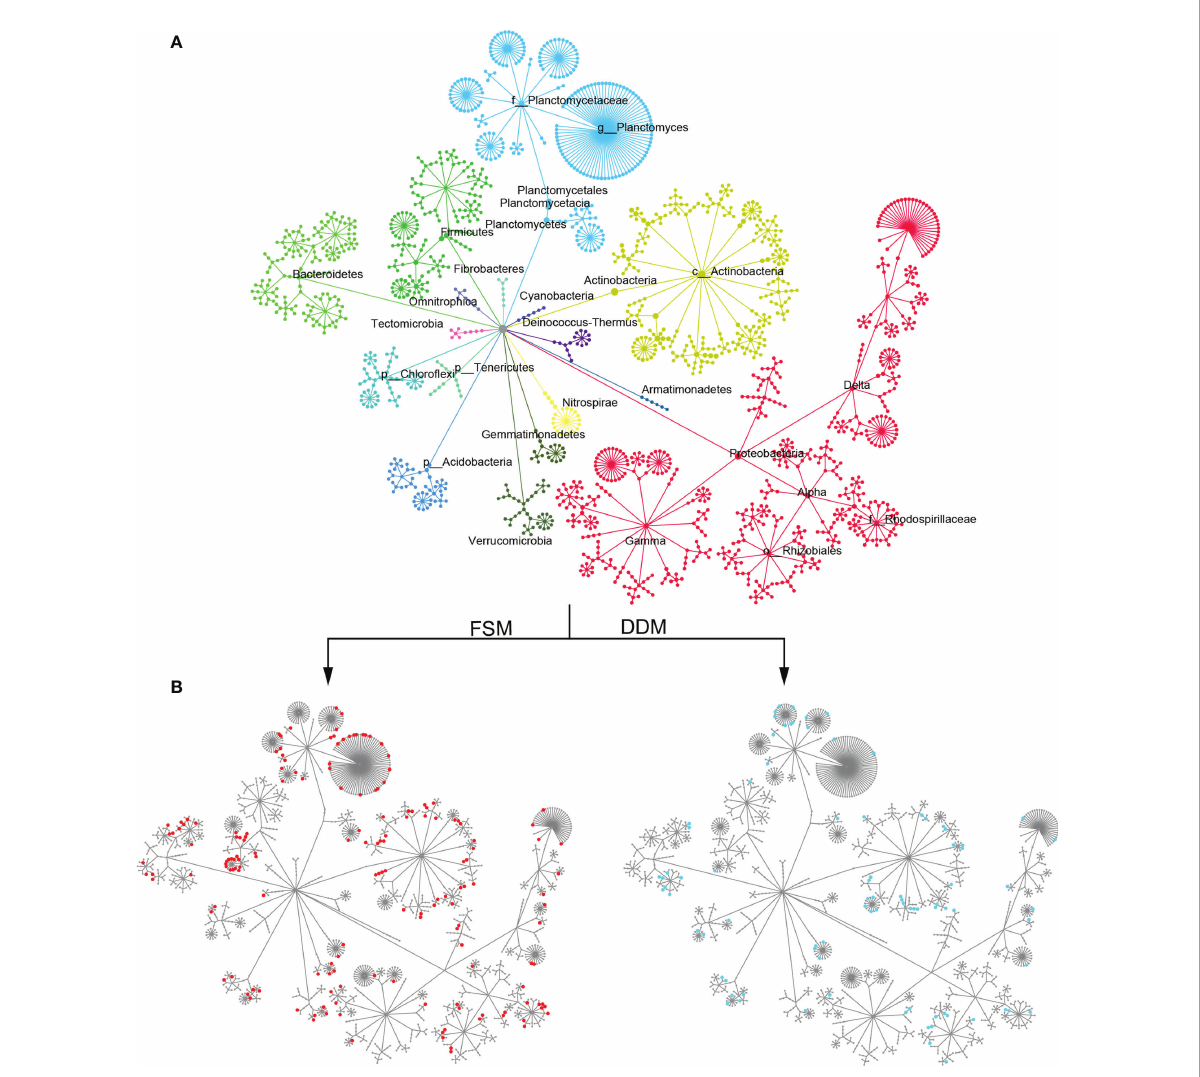
FIGURE 1 (A) A hierarchical taxonomic tree of bacterial communities showing OTU distribution across the different phyla. Nodes correspond to OTUs and edges represent the taxonomic path from the phylum to the OTU level. OTUs were placed at the level with the lowest possible assignment. Clusters are color-coded by their phylum-level assignment and are labeled with the phylum name. (B) A taxonomic tree with the same topology as shown in panel A, but with node sizes that correspond to the positive relative change (z-transformed) in abundance under fl ooding irrigation with fi lm mulch (FSM) or drip irrigation with double fi lm mulch (DDM) stands. Node colors correspond to the level of signi fi cance from highly signi fi cant (red/blue) to not signi fi cant (gray). A soft threshold using a color gradient rather than a hard cutoff was used to denote the level of signi fi cance. Nodes with p ≤ 0.05 are completely